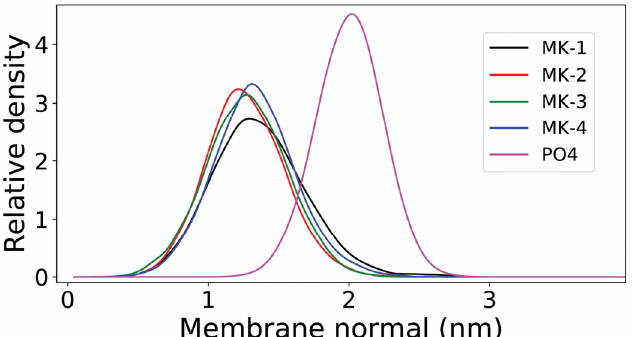
Figure 8. Mass density of the MK quinone headgroup along the membrane normal for MK-1 (black), MK-2 (red), MK-3 (green), and MK-4 (blue). The phosphate group of POPC (PO4) is shown in magenta. Data from both layers were symmetrized. The normal zero corresponds to the center of the bilayer.